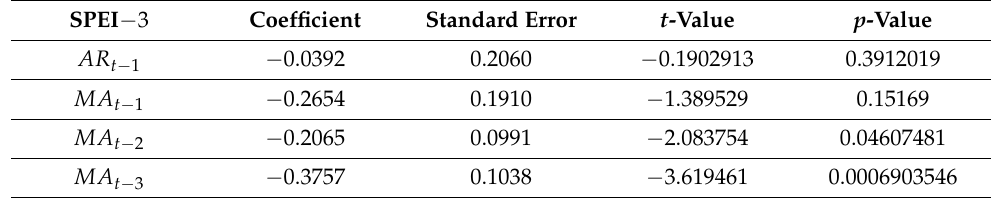
Table 8. SPEI-3 ARIMA (1,1,3) for non-seasonal.